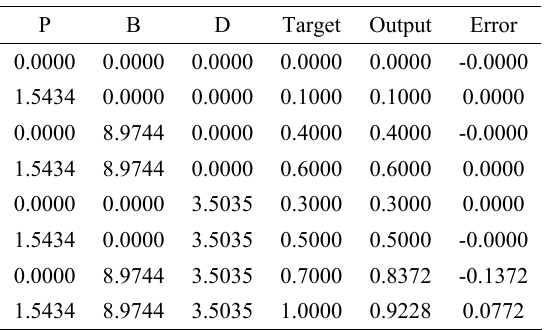
Table 7: Input values, target values and the corresponding output and error values generated by an ANN information fusion technique using entropy identity attributes metrics values.